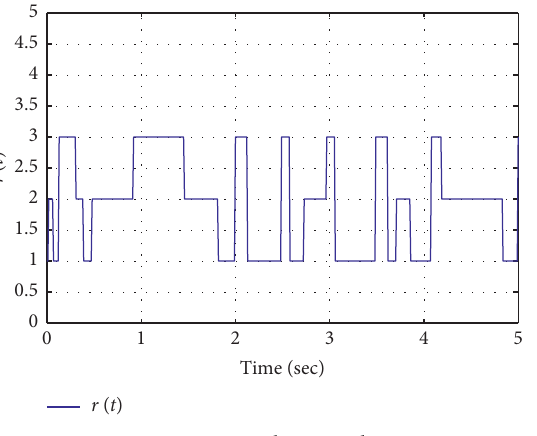
Figure 9: Markov signal.